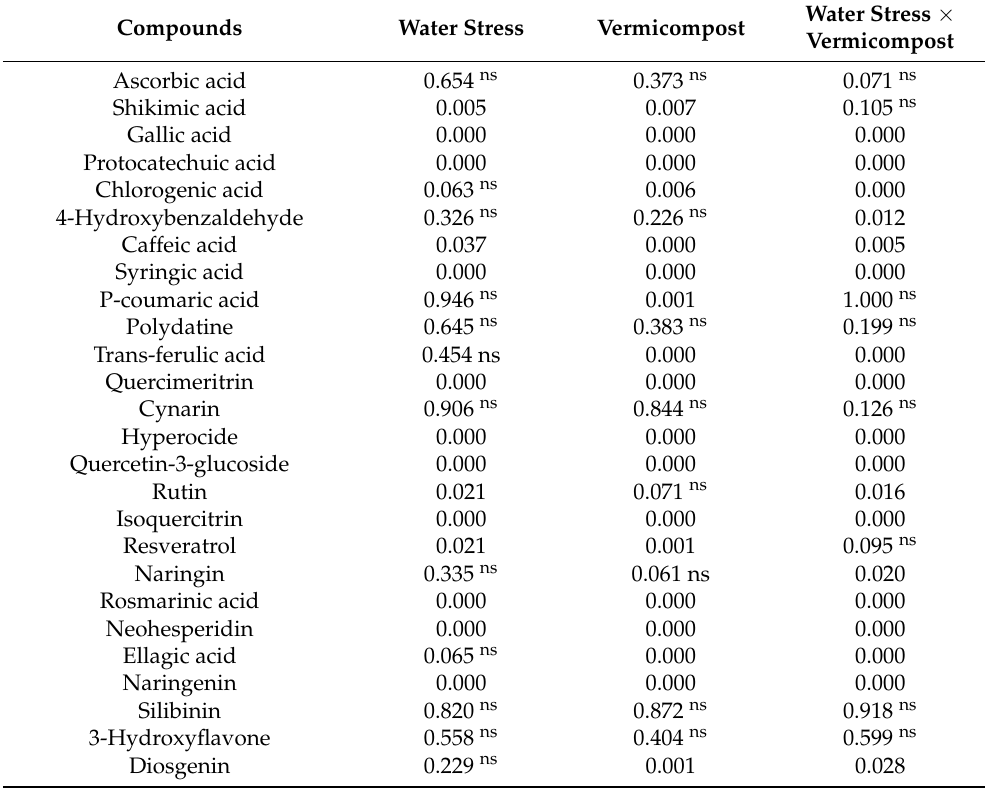
Table 5. Variance analysis of phenolic compounds corresponding to the treatments. Compounds Water Stress Vermicompost